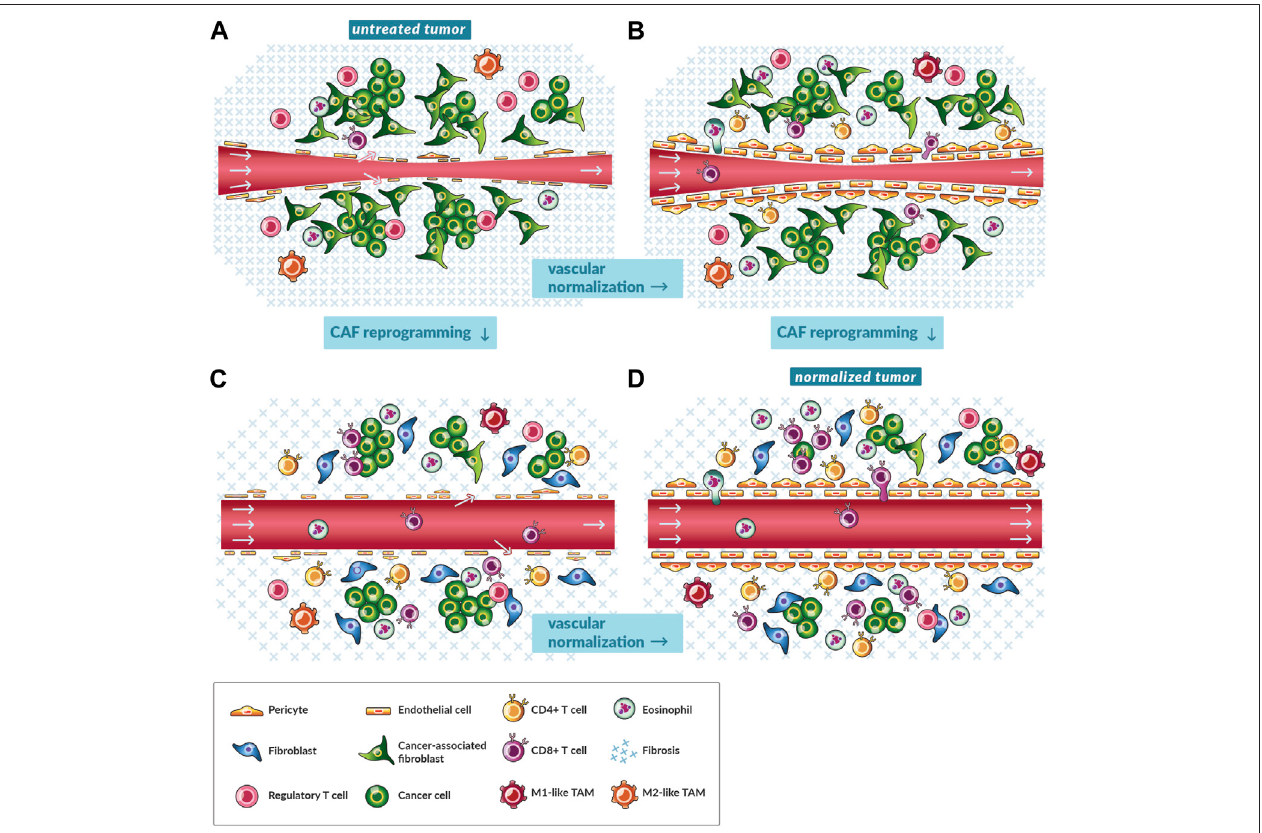
FIGURE 2 | Vascular normalization and reprogramming of cancer-associated fi broblasts shift the microenvironment towards antitumor immunity. (A) A schematic ofamagni fi ed,cross-sectionalviewofasinglebloodvesselinanuntreatedtumor.Apinchpointinthebloodvessel(redtube)andthelackofaconsistentendothelialcell layerforti fi edwithpericytesrestrictsblood fl ow(grayarrows).Thetumorisrepletewithimmunosuppressivecancer-associated fi broblasts(CAFs), fi brosis,andregulatory Tcells(CD4 + CD25 + FOXP3 + )whilelackingCD8 + andothersubsetsofCD4 + Tcells. (B) Aschematicofamagni fi ed,cross-sectionalviewofasinglebloodvesselina tumor treated with vascular normalizing therapy. As the balance of pro- and anti-angiogenic factors shifts towards the latter, endothelial cells are aligned, and blood vessels are forti fi ed with pericytes yet remain compressed by mechanical stress. Perfusion increases especially in tumors with low levels of mechanical stress. Immune cells such as CD8 + T cells more ef fi ciently traf fi c to tumors and transmigrate across the vessel wall. There are fewer immunosuppressive cells because of reduced angiogenic and hypoxia signaling. Vascular normalization by immune checkpoint inhibitors could rely on the accumulation of activated eosinophils. (C) A schematic of a magni fi ed, cross-sectional view of a single blood vessel in tumor treated with CAF reprogramming therapy. As CAFs shift to quiescent fi broblasts, they produce and maintain lower levels of fi brosis. Mechanical stress is alleviated and vessels are decompressed. Perfusion increases. Immune cells such as CD8 + T cells fl ow through tumors and migrate the interstitial space because of less immunosuppressive CAF and hypoxia signaling. Also, there is less physical restriction of migration by components of fi brosis, such as collagen. (D) A schematic of a magni fi ed, cross-sectional view of a single blood vessel in tumor treated with both vascular normalizing and CAF reprogramming therapy. Given the reduced signaling and physical barriers, immune cells such as CD8 + T cells ef fi ciently traf fi c to tumors, negotiate transport through the vessel wall, and penetrate to clusters of cancer cells.